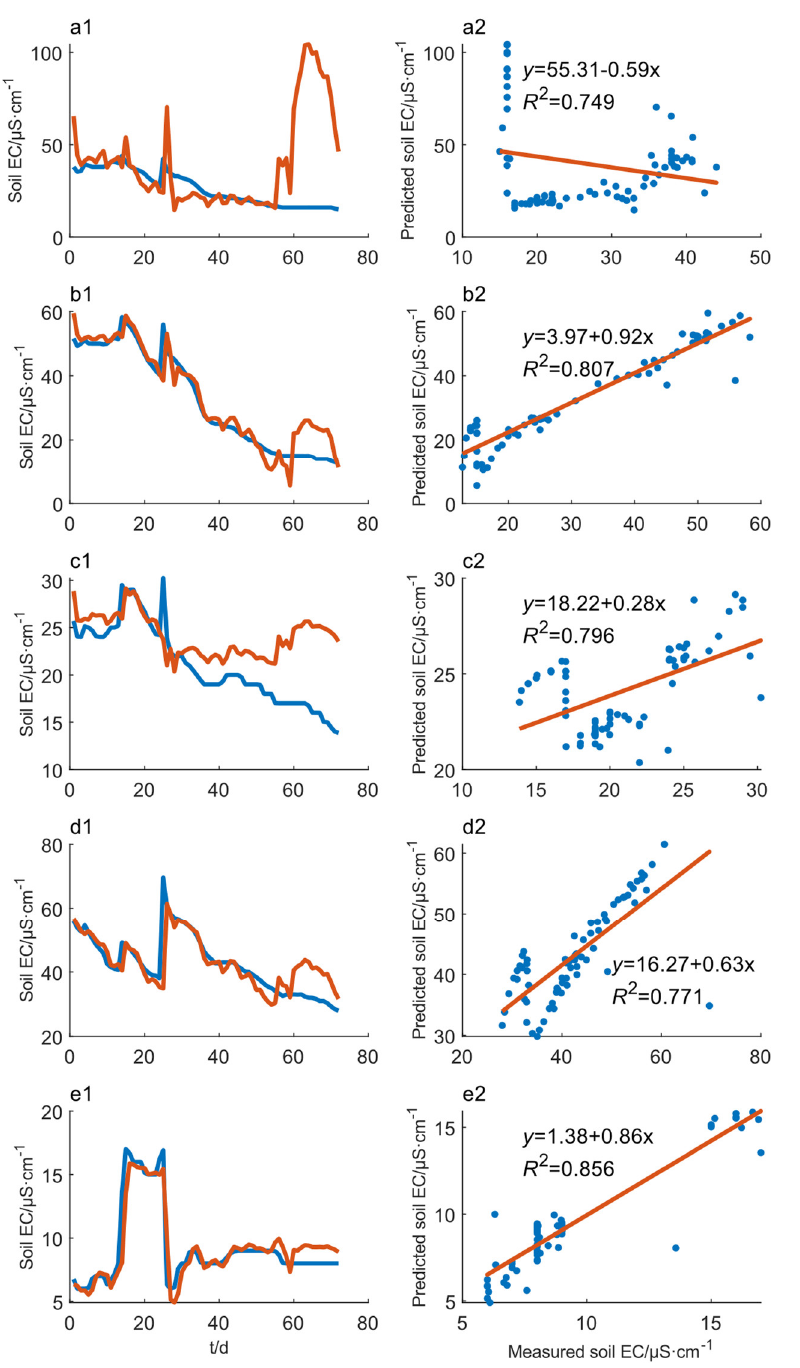
Figure 16. Comparison of the MLNN model in different datasets for SEC. ( a – e ) represents node 1–5, respectively; in ( a1 – e1 ), the blue line represents the measured SEC, and the orange line represents the predicted SEC; ( a2 – e2 ) represents the regression fitting between the predicted SEC and measured SEC.